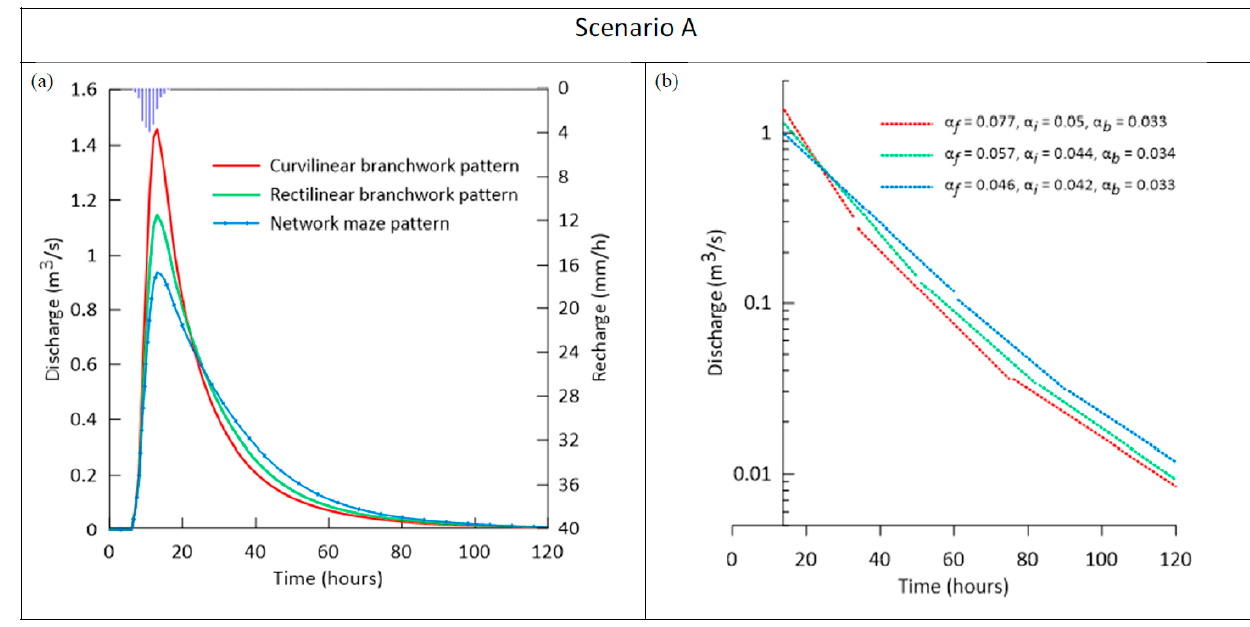
Figure 12. ( a ) The spring hydrographs were obtained from the different conduit network patterns in diffuse recharge (scenario A). ( b ) Recession curves ( α f , α i , and α b are the fast flow, intermediate flow, and baseflow recession coefficients, respectively). The blue lines at top of graph ( a ) indicate recharge.